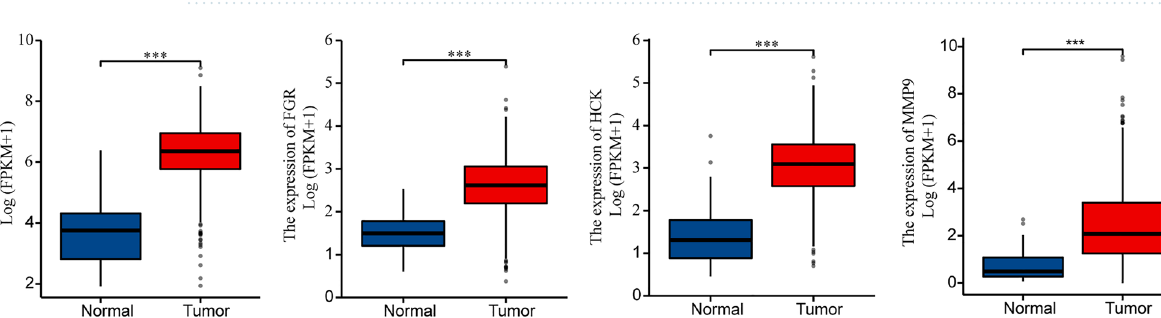
Figure 3. PPI network construction and analysis of key genes. ( A ) The subnetwork with the highest score. ( B ) The hub genes network. ( C ) The overlapped key genes.